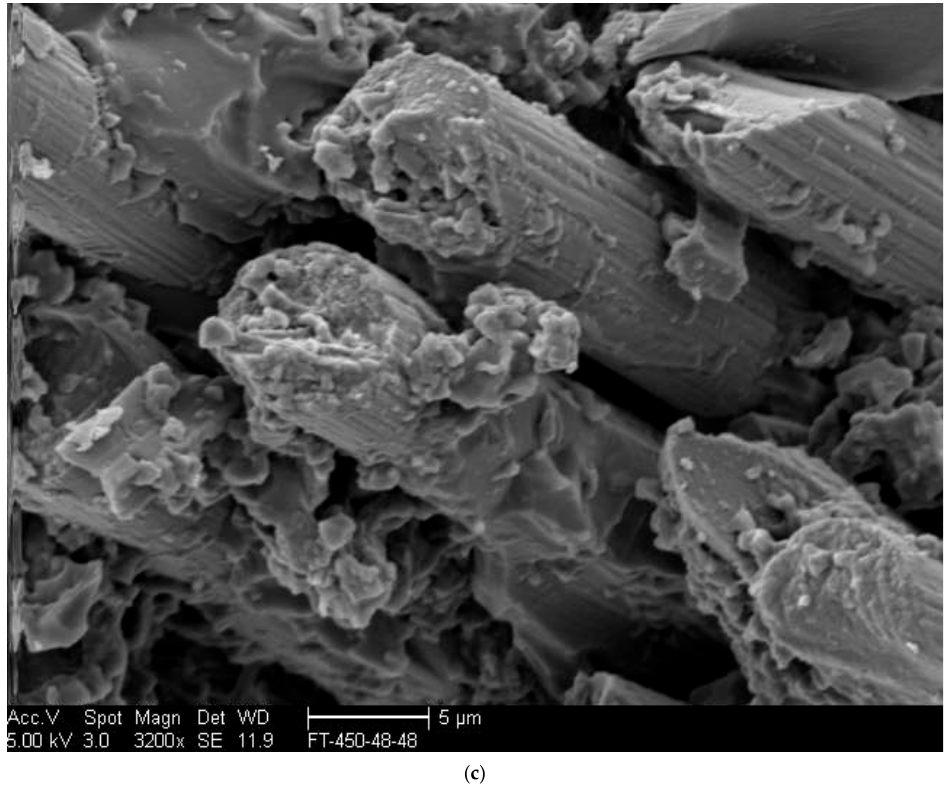
Figure 2. ( a ) Scanning Electron Micrograph of specimen after 4 h of exposure at 232 °C; ( b ) Scanning Electron Micrograph of specimen after 16 h of exposure at 232 °C; ( c ) Scanning Electron Micrograph of specimen after 48 h of exposure at 232 °C.